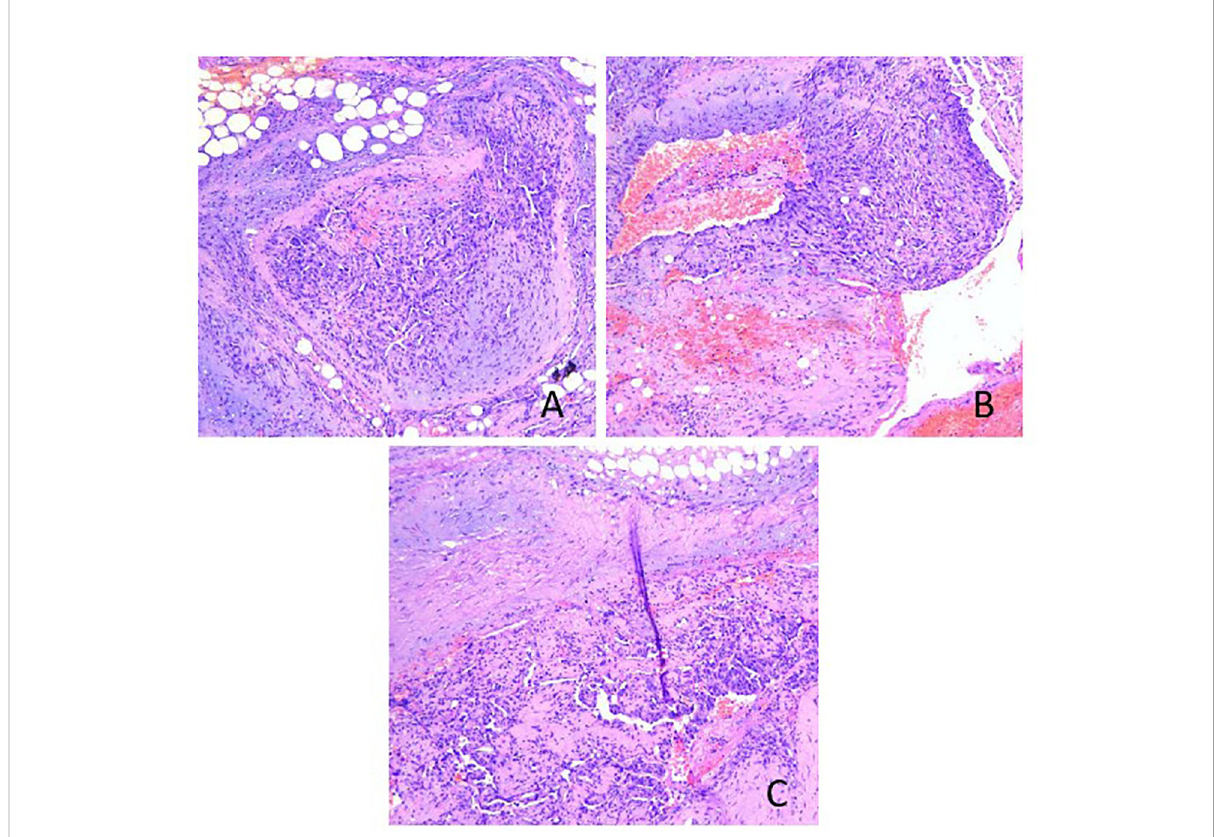
FIGURE 2 Hematoxylin & eosin staining of the L3 biopsy: (A) The tumor tissue consisted of well-differentiated vascular lumen, which grew in fi ltratively around; (B) the lumen was irregular in size and shape, communicating with each other to form anastomosis or communication, and erythrocytes were seen in the lumen; (C) the lumen was lined with monolayer, dark-stained endothelial cells, partly forming papillae in the lumen, and the tumor cells were heterogeneous with large, dark-stained, heterogeneous